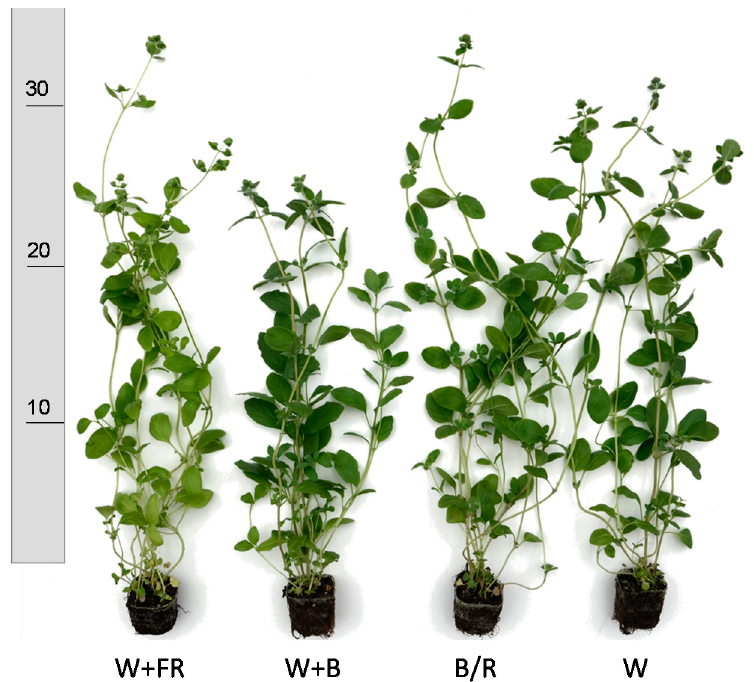
Figure 4. Exemplary representation of the development stage of marjoram after 38 d of cultivation for each light treatment, respectively. Plant length shown in cm.